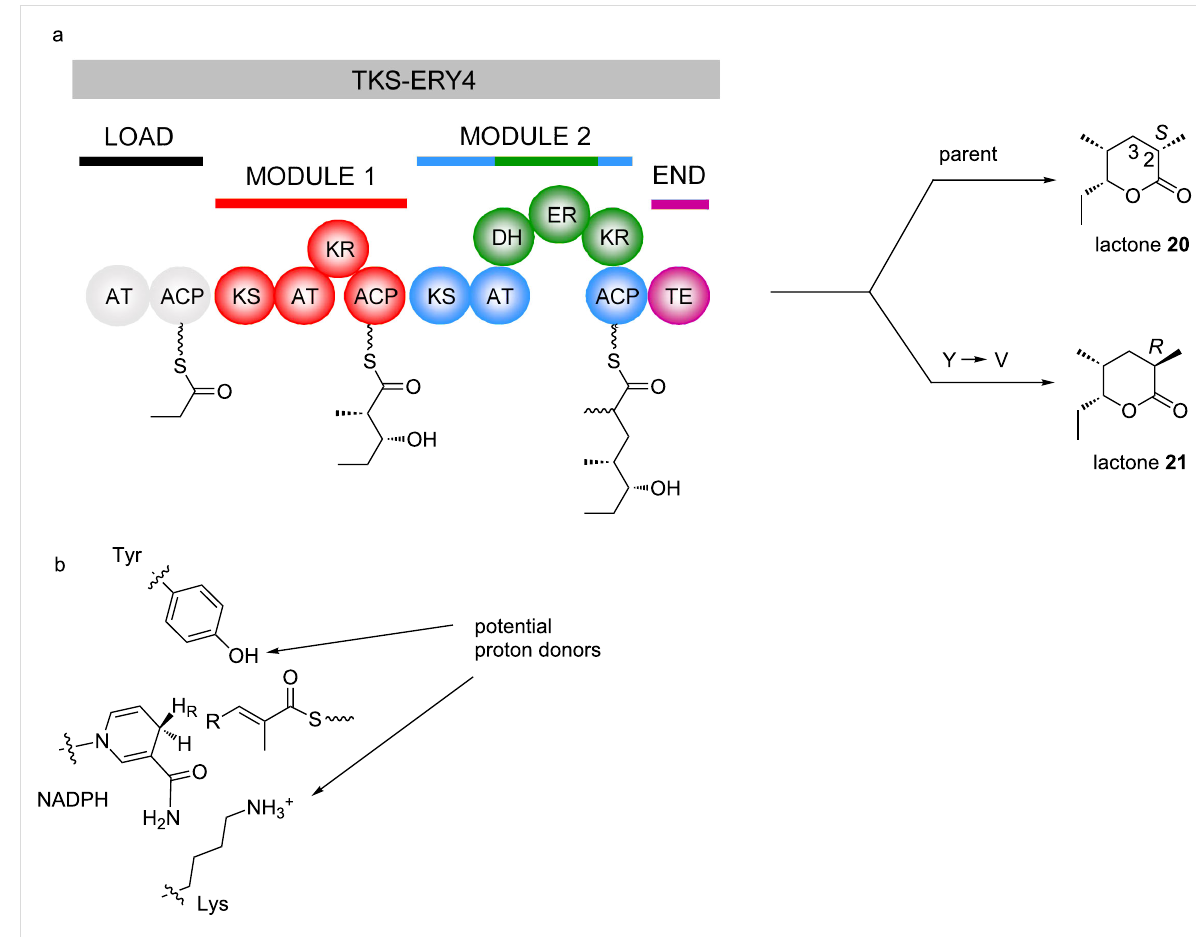
Figure 18: a) PKS engineered to test the role of the ER stereospecificity residues [115]. TKS-ERY4 was created by replacing the KR domain of DEBS module 2 (within the context of DEBS 1-TE) with the ‘reductive loop’ (DH-ER-KR) from DEBS module 4. This PKS gives rise to lactone 20 incorporat- ing a (2 S )-methyl group, consistent with the presence of the conserved Y in the active site. Site-directed mutation of this Y to the alternative V resulted in a complete shift in stereochemistry to give lactone 21 , with (2 R )-methyl stereochemistry. b) Model for reduction by ER domains from the 4 ′ - pro - R hydride of NADPH. When the Tyr is present, it acts as the proton donor following reduction to give the (2 S )-methyl. In its absence, the Lys residue on the opposite side of the active site acts as the general acid, yielding the (2 R )-methyl.